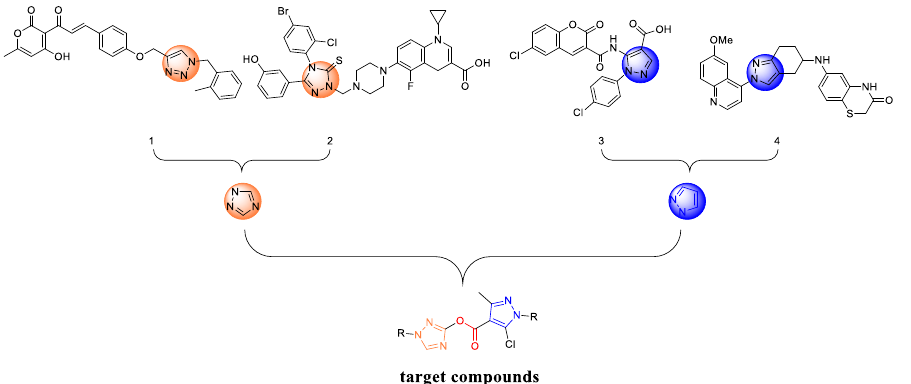
Figure 2. The design of the target scaffold.